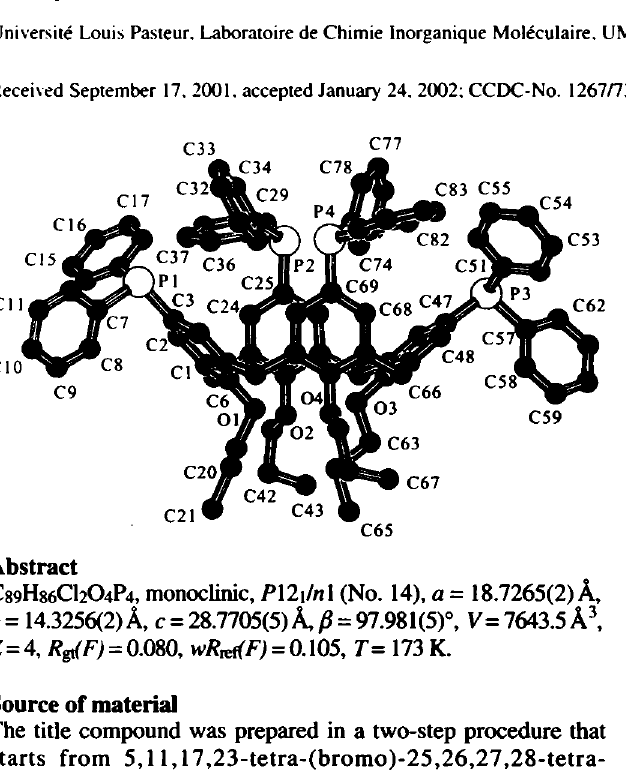
Table 2. Atomic coordinates and displacement parameters (in Â 2